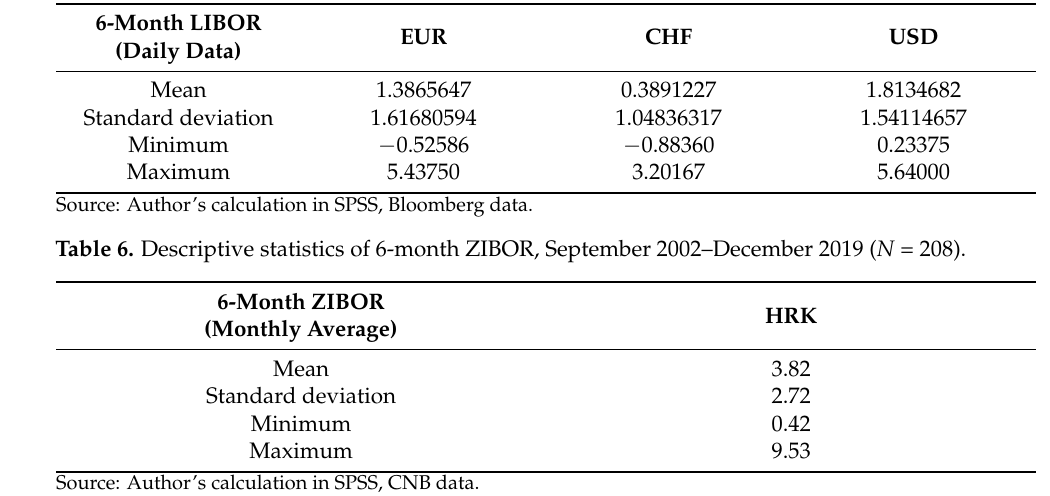
Figure 5. Six-month ZIBOR, monthly average for the September 2002–December 2019 period.